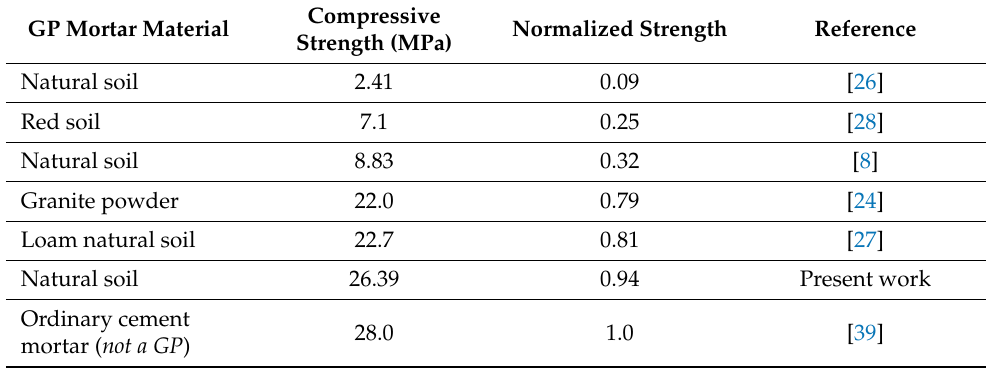
Table 3. Compressive strength comparison of NS-based GP with those in published works. GP Mortar